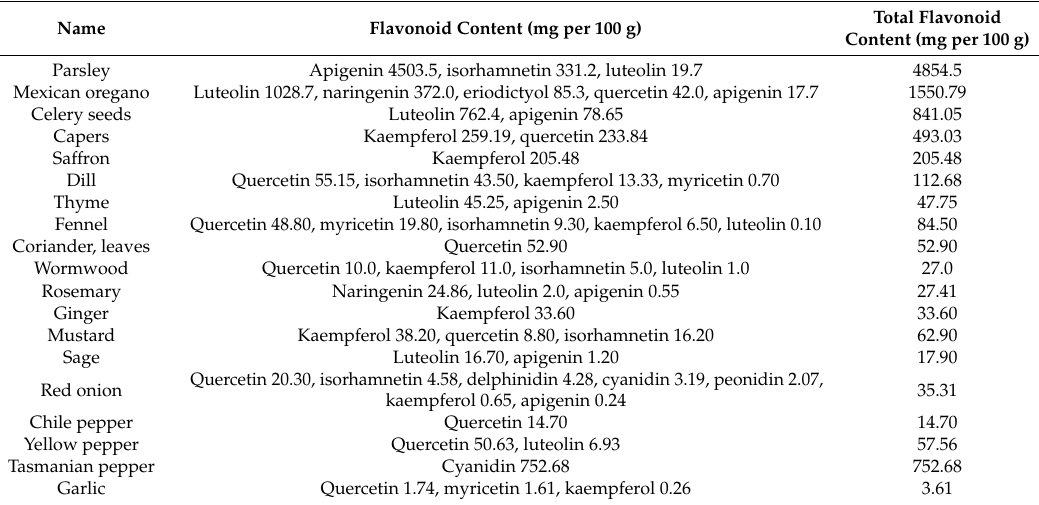
Table 2. Flavonoid content in spices from the USDA (U.S. Department of Agriculture) database on flavonoids content of selected foods, release 3.1 (2014)